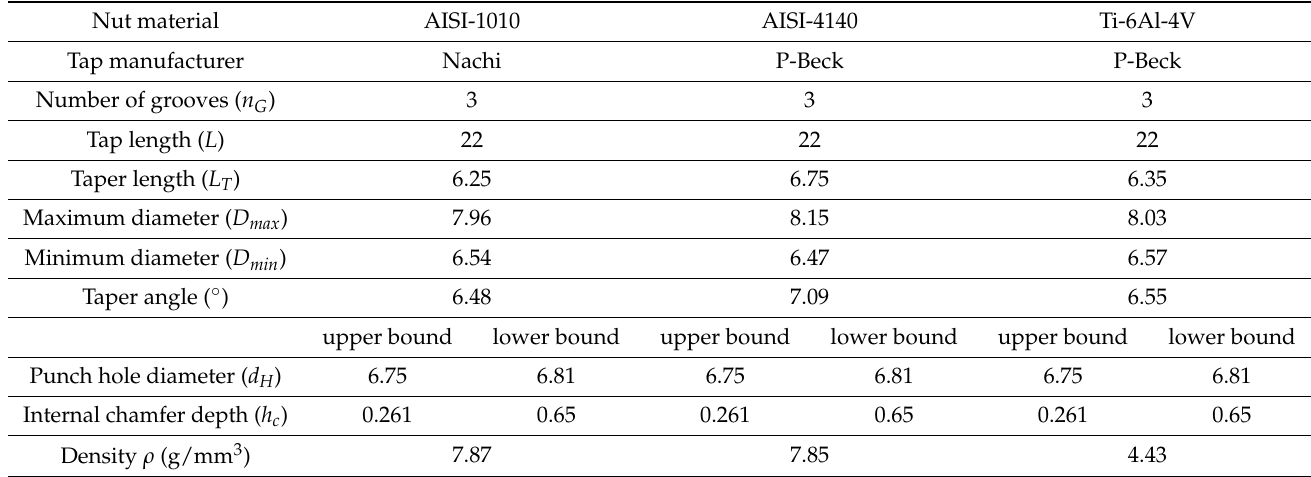
Figure 10. Tapping torque curves for different materials and cutting speeds. Table 3. The parameters of tap and nut for three different